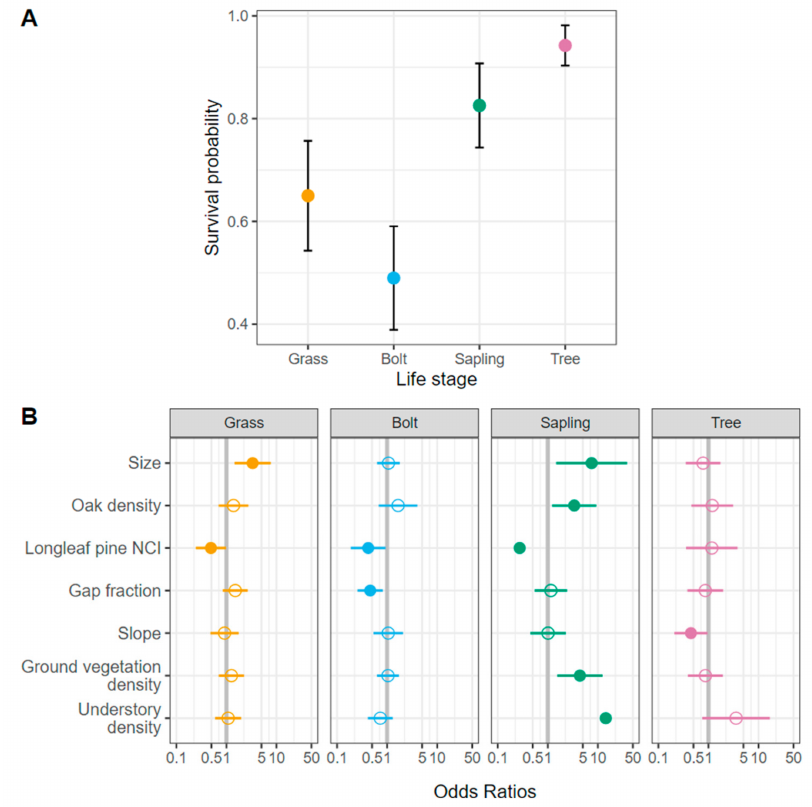
Figure 3. ( A ) Survival across life stages; error bars represent 95% confidence intervals of survival probabilities for each life stage and colors are unique to life stage and this palette will be used throughout following figures. ( B ) Plots depicting standardized odds ratio estimates ( ± 2 SE) from GLMMs assessing correlates of longleaf pine survival across life stages. Filled circles indicate significant parameter estimates ( p < 0.05).